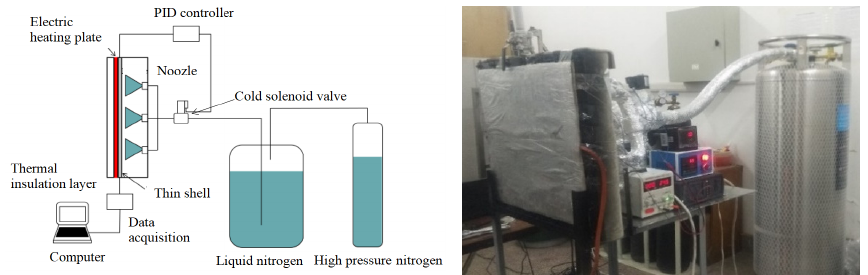
Figure 2. Schematic diagram of the experimental system under the heating mode of the electric heating sheet (high heat flux) and experimental bench.